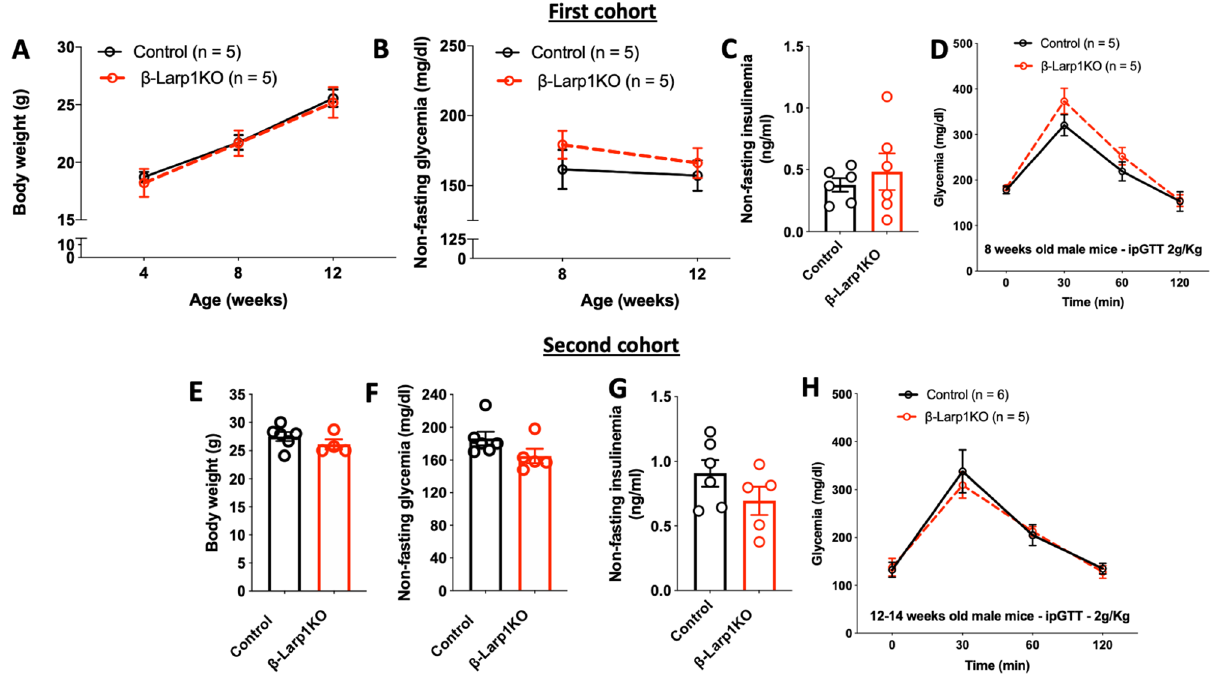
Figure 4. β-Larp1KO mice have normal glucose homeostasis. ( A ) Body weight, ( B ) non-fasting glycemia ( C ) non-fasting insulinemia and ( D ) intraperitoneal glucose tolerance test (ipGTT) in the first cohort of male β-Larp1KO mice; ( E ) body weight, ( F ) non-fasting glycemia ( G ) non-fasting insulinemia and ( H ) ipGTT in the second cohort of male β-Larp1KO